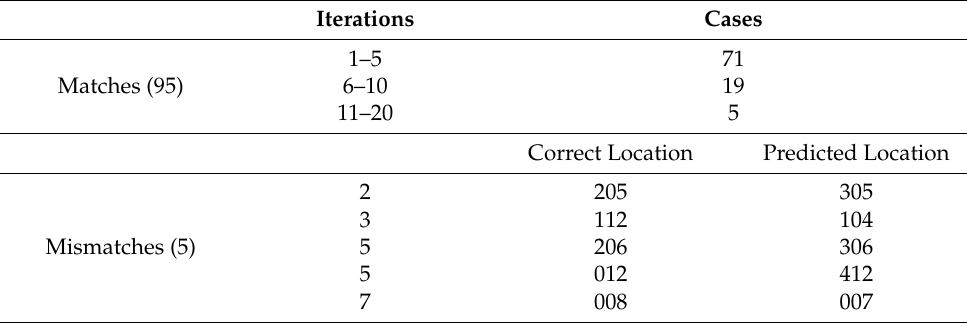
Table 5. Test results using heave, roll, and pitch motions as criteria. Iterations